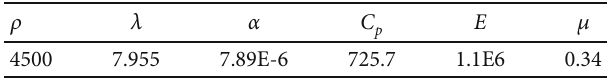
Table 1: Material properties of titanium